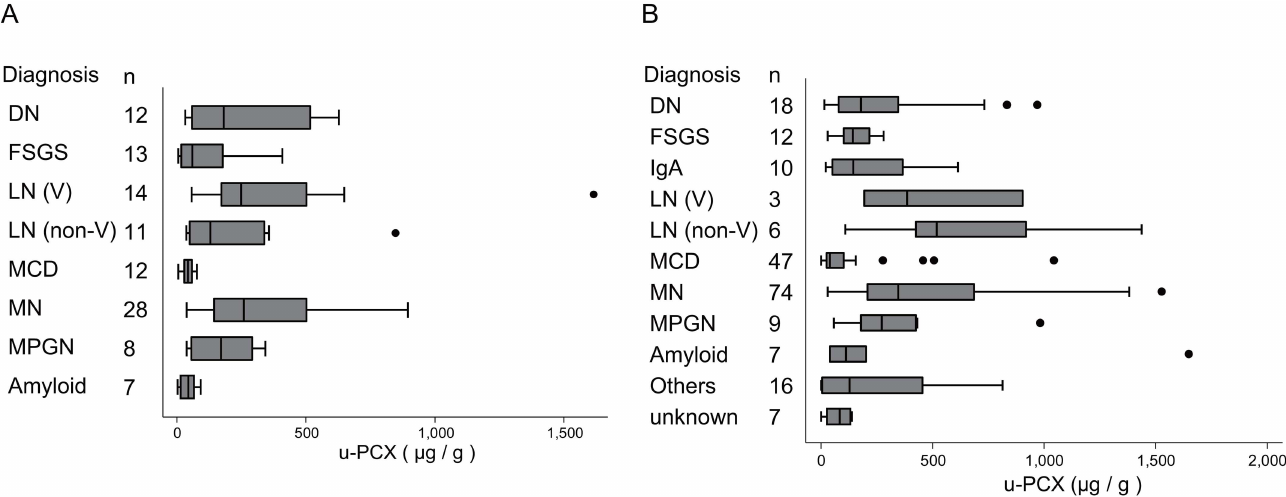
Fig 1. Levels of u-PCX in each kidney disease. MCD: minimal change disease; MN: membranousnephropathy; FSGS: focal segmental glomerulosclerosis; MPGN: membranoproliferative glomerulonephritis; LN: lupus nephritis; DN: diabetic nephropathy; and amyloidosis. LN was classified into two subclass; LN (V) and LN (non-V) accordingto the 2003 ISN/RPS classification. Class V lesion was definedas global or segmental sub-epithelial immune deposits or their morphologic sequelae,with or without class III/IV lesion. (A) Training cohort. (B) Validationcohort.